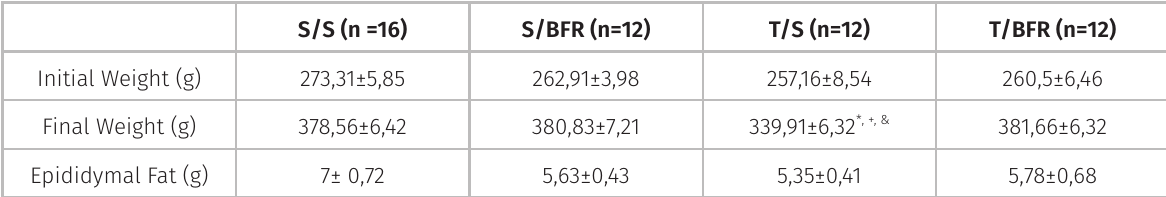
Table I. Initial weight, final weight and epididymal fat of rats from the sedentary (S/S) groups, sedentary with blood flow restriction (S/BFR), trained (T/S), and trained with blood flow restriction